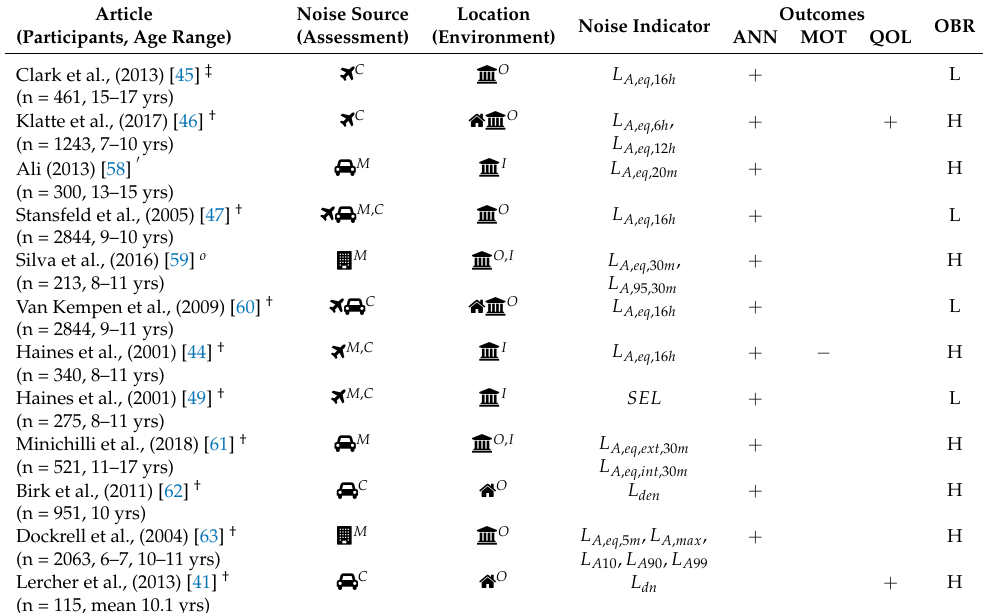
Table 9. Well-being dimensions-based studies. ANN corresponds to annoyance, MOT to motivation, and QOL to quality of life. For explanation of symbols and notations, see caption of Table 5.